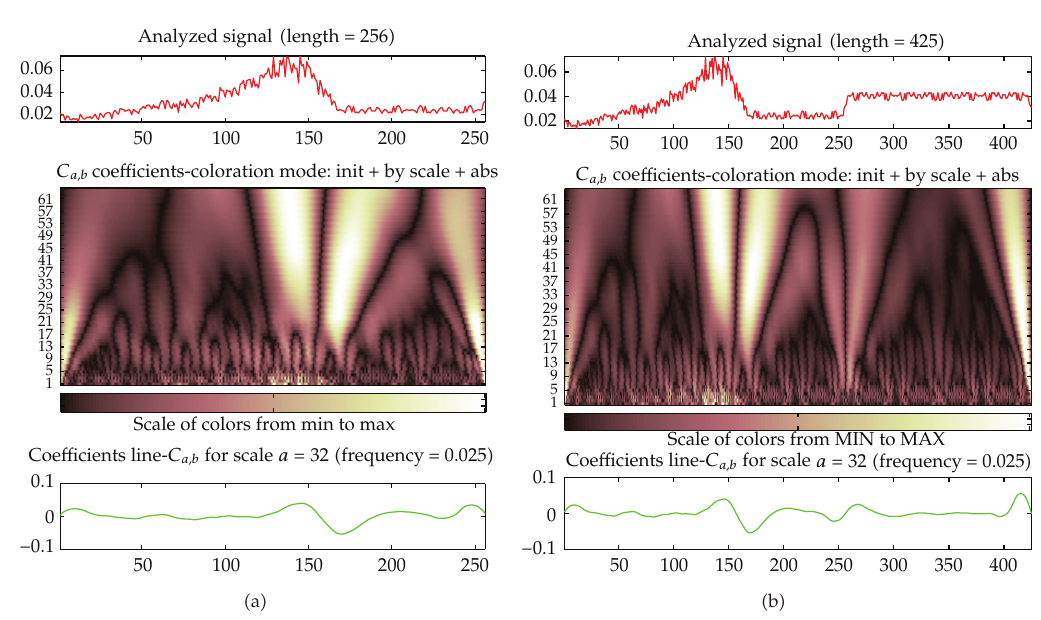
Figure 3: (cid:5) a (cid:6) First assumption. Inclusion of the first period, (cid:5) b (cid:6) first assumption. Inclusion of the first and second periods.